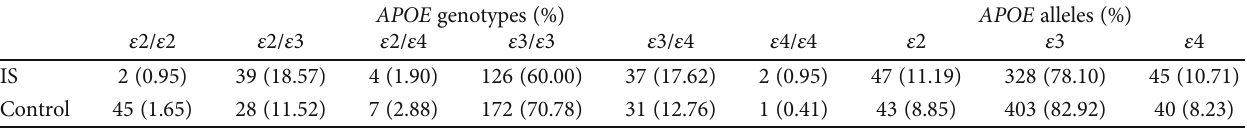
Table 2: Distribution frequencies of APOE genotype and allele in the IS and the control groups. APOE genotypes (%)